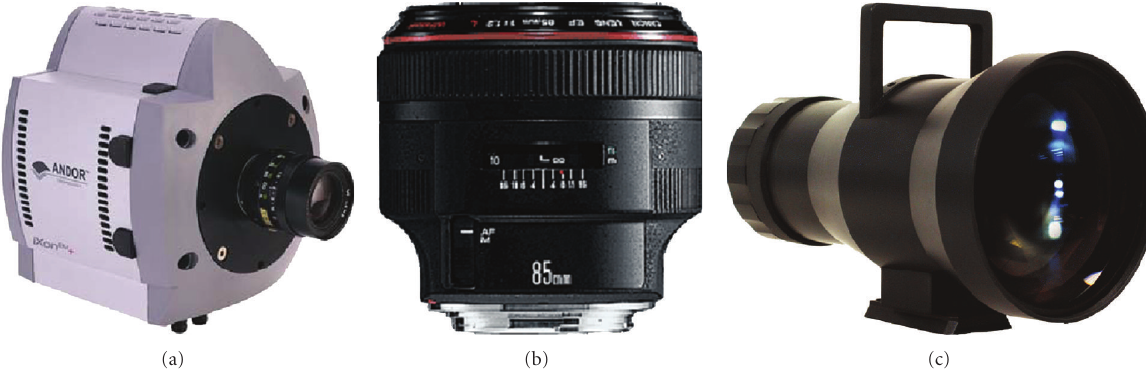
Figure 10: Possible commerciallyavailable parts for MegaTORTORA. (a) Andor iXon EM +888 1024 × 1024 EM-CCD with 13 μ m pixel size, up to 95% quantum e ffi ciency, 9 frames per second frame rate, and less than 1 e − read-out noise in high gain regime. (b) Canon EF 85f/1.2 L USM II objective, which may provide 9 × 9 degree field of view with 31 (cid:2)(cid:2) pixel scale for this CCD. (c) Marshall Electronics 140 mmf/1.0 lens, which will give 5 . 4 × 5 . 4 degree field with 19 (cid:2)(cid:2) pixel scale.